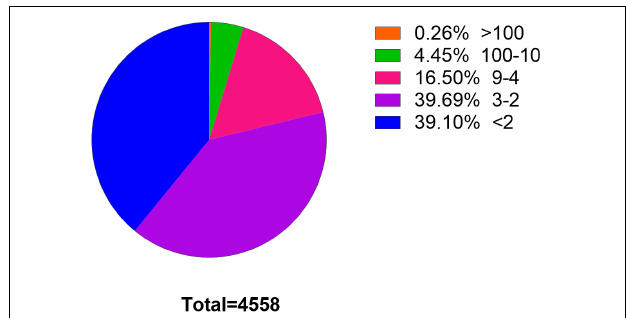
FIGURE 2 | Statistics of circRNAs BSj reads. Among these 4,558 genes, only 0.26% has a reading of more than 100 BSj; 4.45% has a reading of 10–100 BSj reads; 16.5% has a reading of 4–9 BSj reads; while 39.69% for 2–3 BSj reands and 39.10% less than 2 BSj reads.